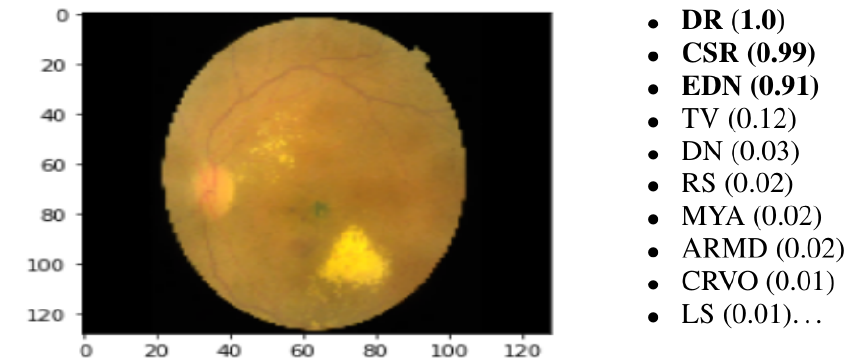
Figure 5. An example of an output image with the top 10 OD